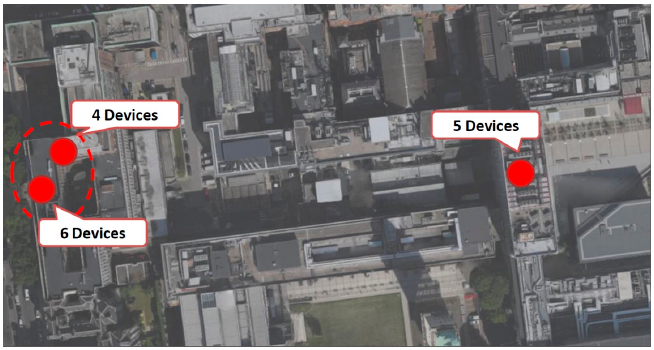
Figure 13. Geographical distribution of participants.